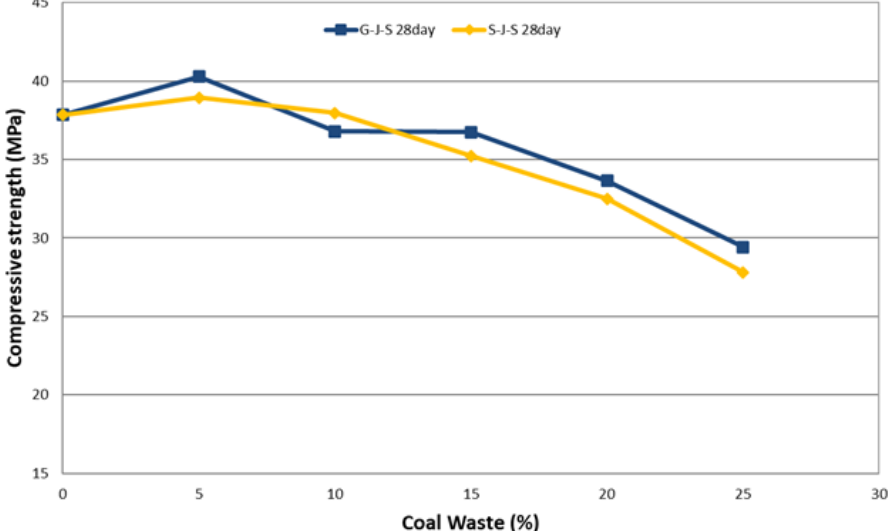
Figure 10. Effect of type and amount of coal waste on the compressive strength after 28 days .